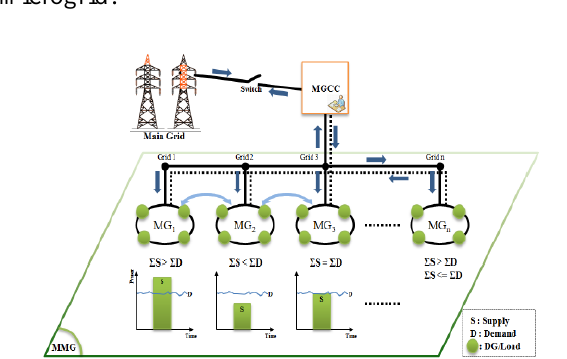
Figure 1. A Schematic representation of Multi-microgrid (a microgrid central controller